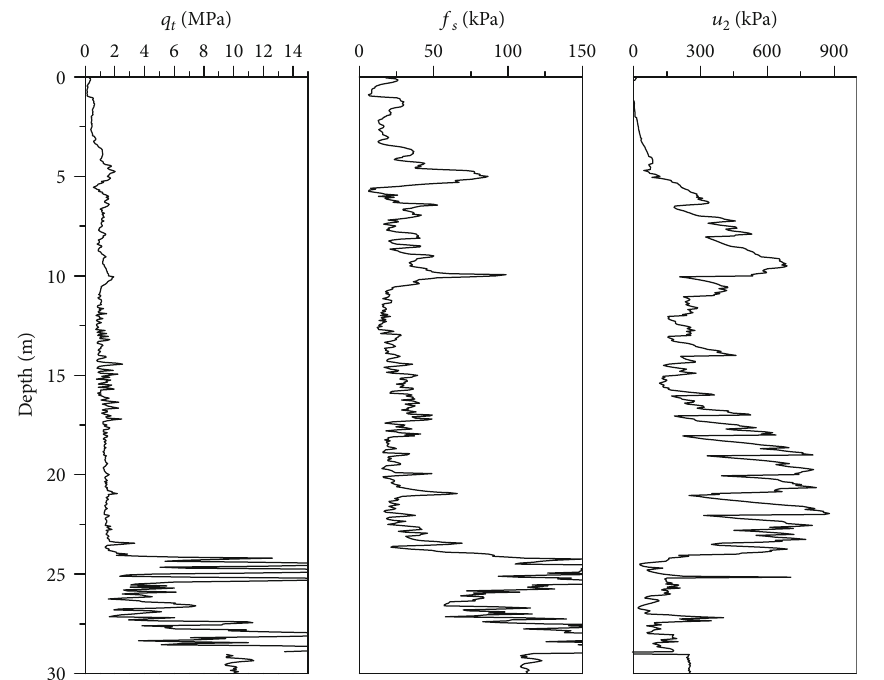
Figure 3: Typical CPTU soundings recorded at Hongzhuang station, Suzhou.